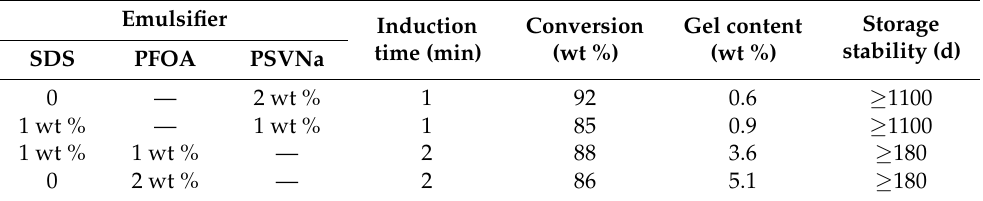
Table 1. Influence of emulsifier on emulsion polymerization.